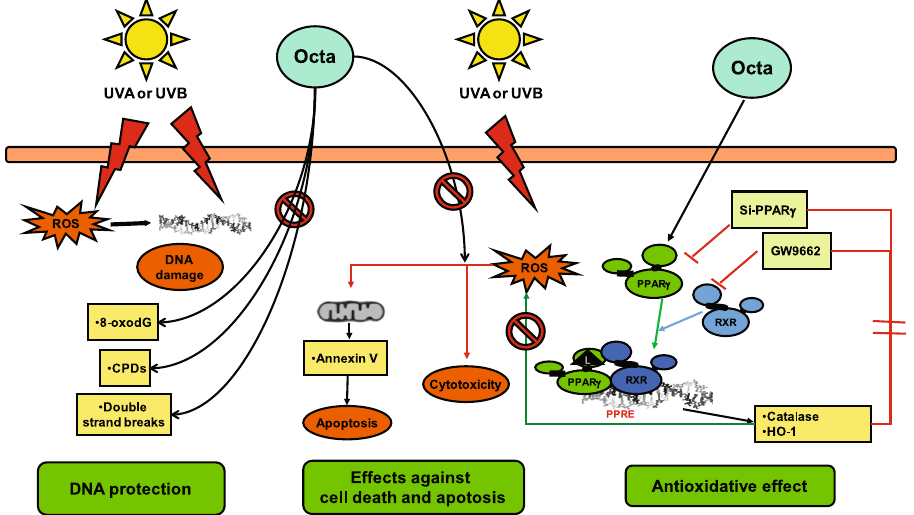
Figure 7. Summary scheme of possible role of PPAR γ activation in counteracting UV-induced damage. The activation of PPAR γ by Octa exerts a protective effect against UVA- and UVB-induced damage on normal human keratinocytes, the major target cells of UV radiation. Octa promotes the antioxidant defence and counteracts the UV-induced DNA damage and